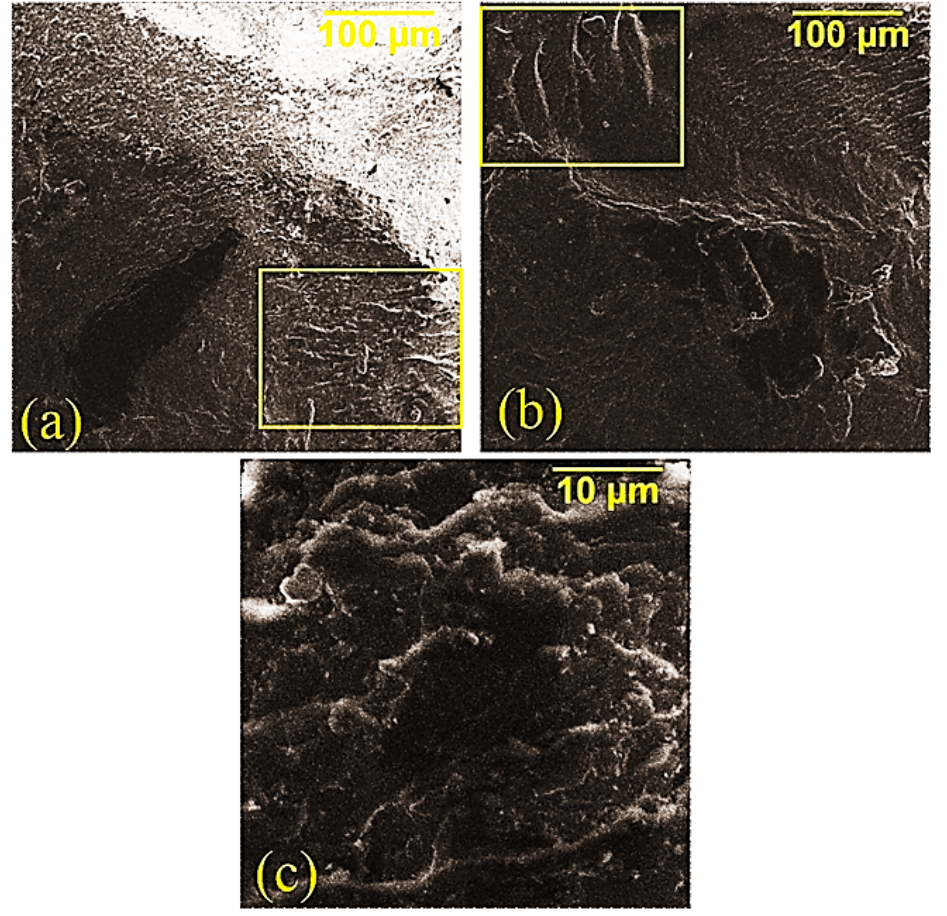
Figure 5. SEM data of a polyester composite modified with microwave-treated MWCNTs: ( a ) 500 × : ( b ) 500 × : ( c ) 5000 ×.